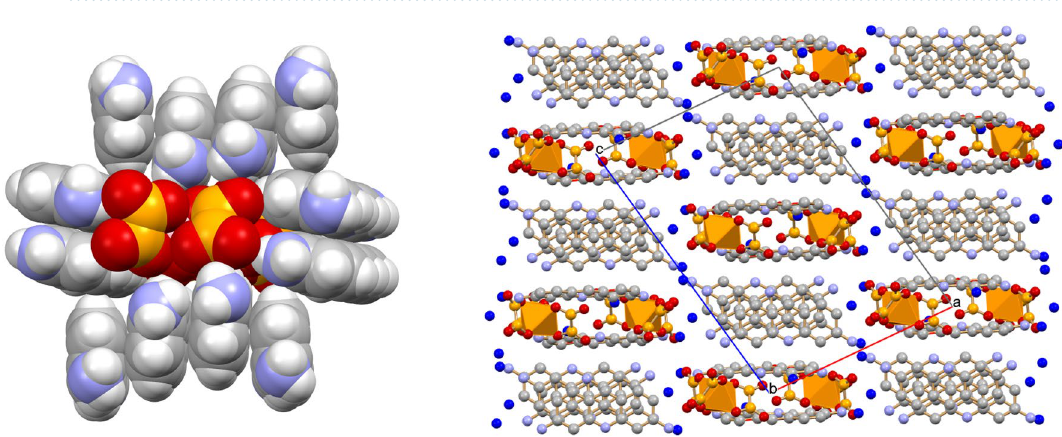
Figure 5. (Left) The proflavinium cations enveloping the [Ga(ox) 3 ] 3– anions in crystalline [HPF] 3 [Ga(ox) 3 ]·4H 2 O; (right) the packing in crystalline [HPF] 3 [Ga(ox) 3 ]·4H 2 O viewed along the crystallographic b -axis. O W in blue; H atoms omitted for